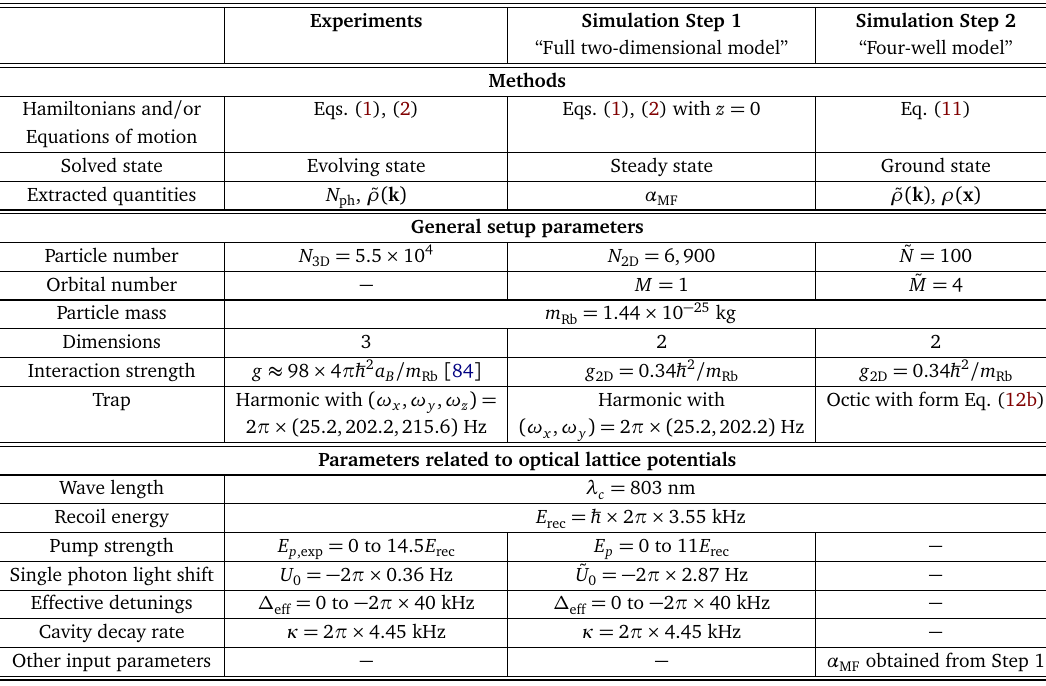
Table 1: Summary of the experimental and computational methods and parameters. Here a is the Bohr radius. B